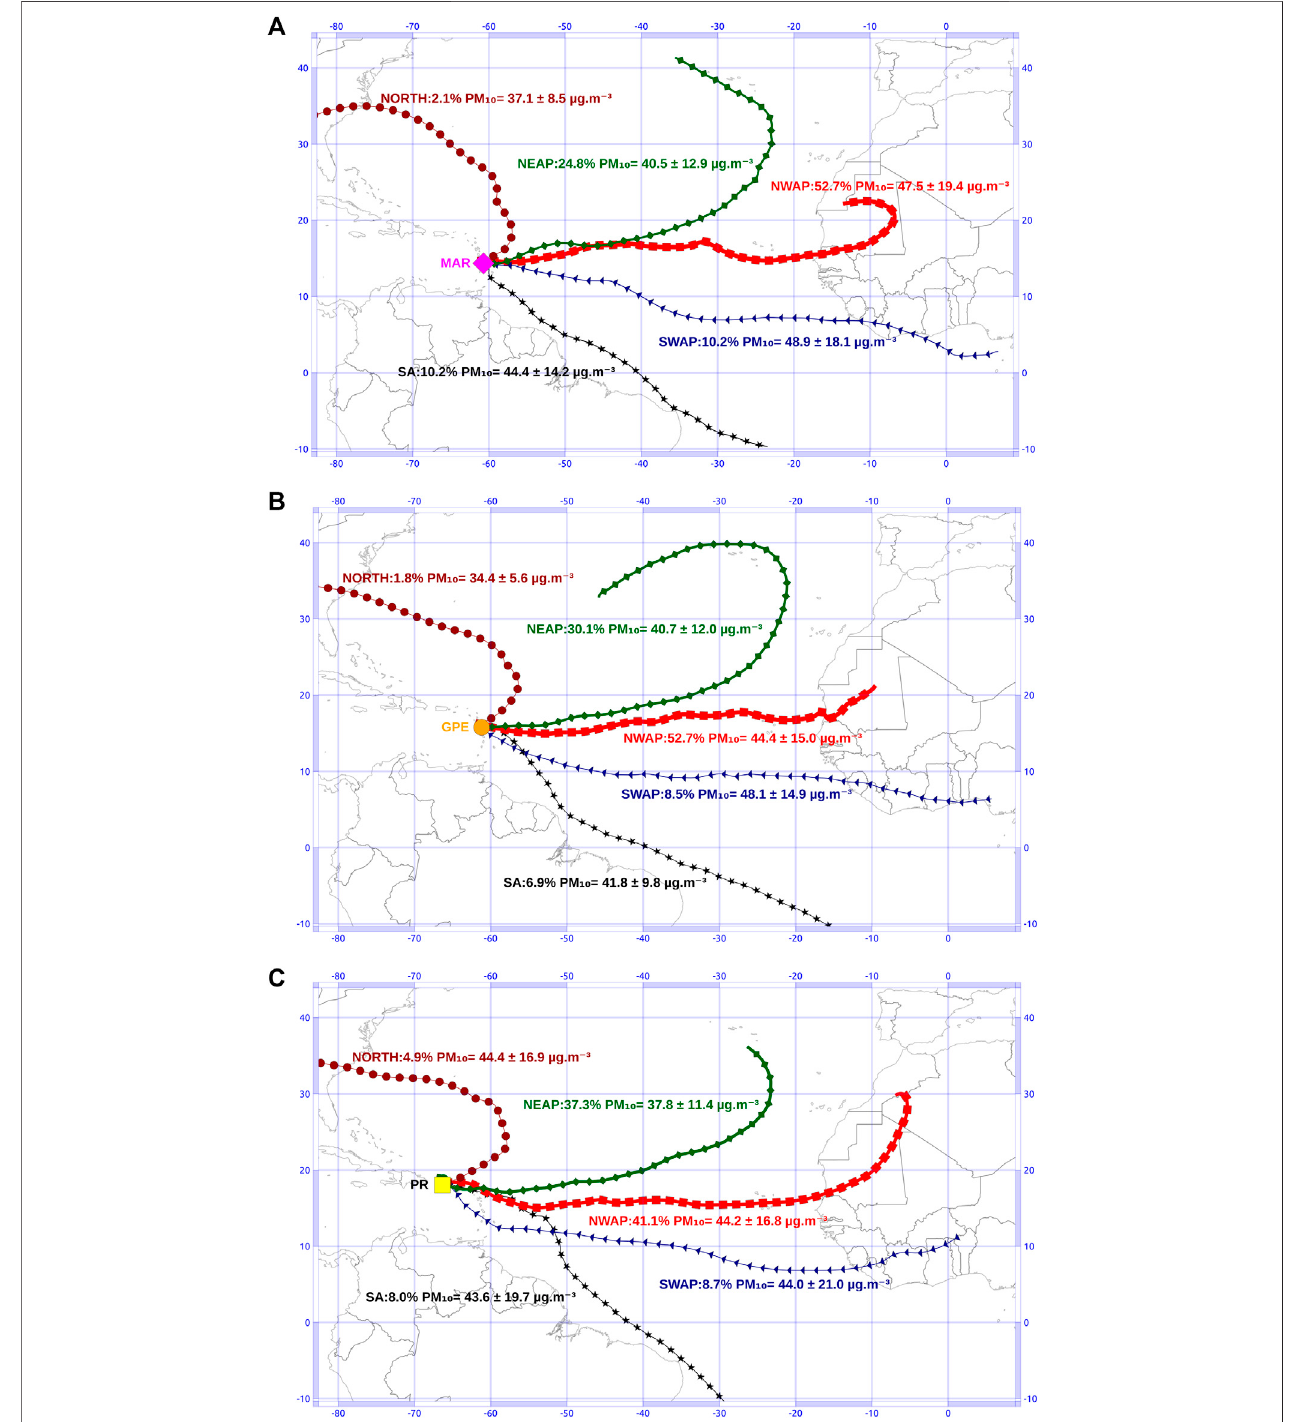
FIGURE 6 | Cluster of daily back trajectories (in percentage) with their descriptive statistics (Mean ( (cid:2) M ) , Standard deviation ( σ )) for (A) Martinique (MAR), (B) Guadeloupe (GPE) and (C) Puerto-Rico (PR) from 2006 to 2016 associated with desert dusty days ( PM 10 ≥ 28 μ g/m 3 ) by path according to Euphrasie-Clotilde et